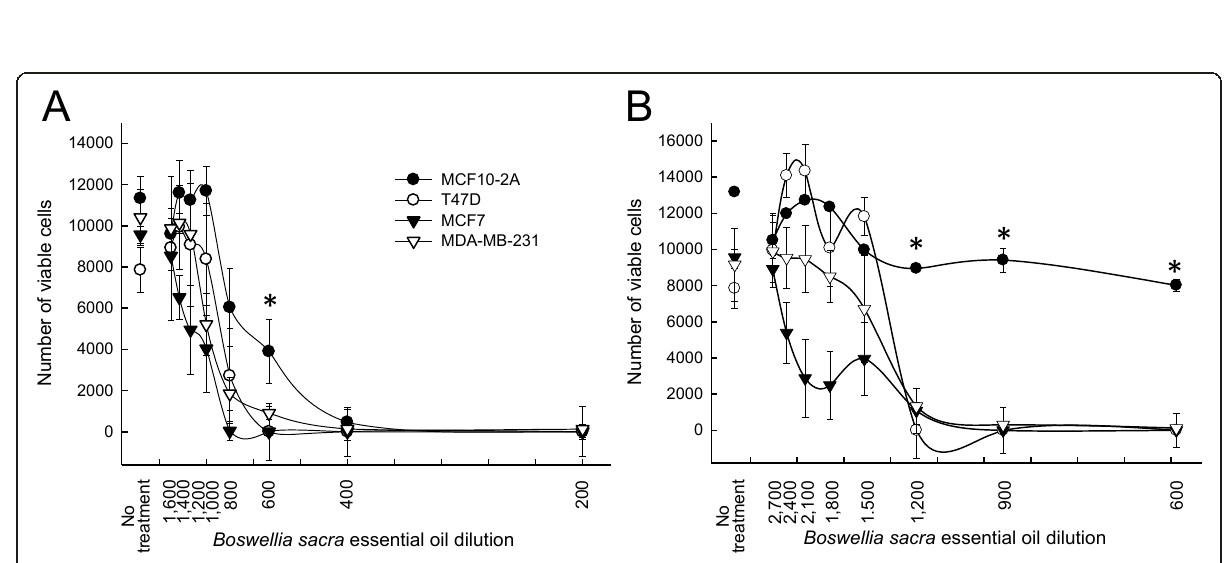
Figure 2 Breast cell viability in response to Boswellia sacra essential oil exposure . Human breast cells (5x10 3 ) were seeded in each well of 96-well tissue culture plates in triplicate. Following adherence, cells were treated with Boswellia sacra essential oil hydrodistilled at (A) 78 o C or (B) 100 o C for 12 hours. Cell viability was determined using the colometric XTT assay at 24 hours after essential oil treatment. Data are presented as mean ± SEM from at least 4 independent experiments. * indicates statistical differences between essential oil-treated breast cancer cells and immortalized breast cells ( P <